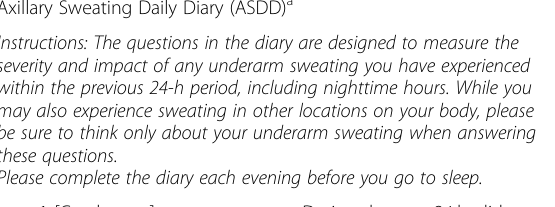
Table 1 Axillary Hyperhidrosis Patient Measures (AHPM) Axillary Sweating Daily Diary (ASDD)